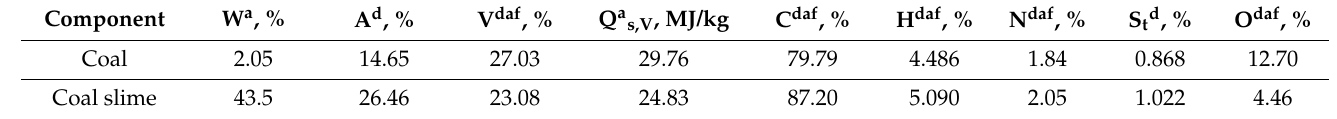
Table 1. Proximate and ultimate analysis of components used in the